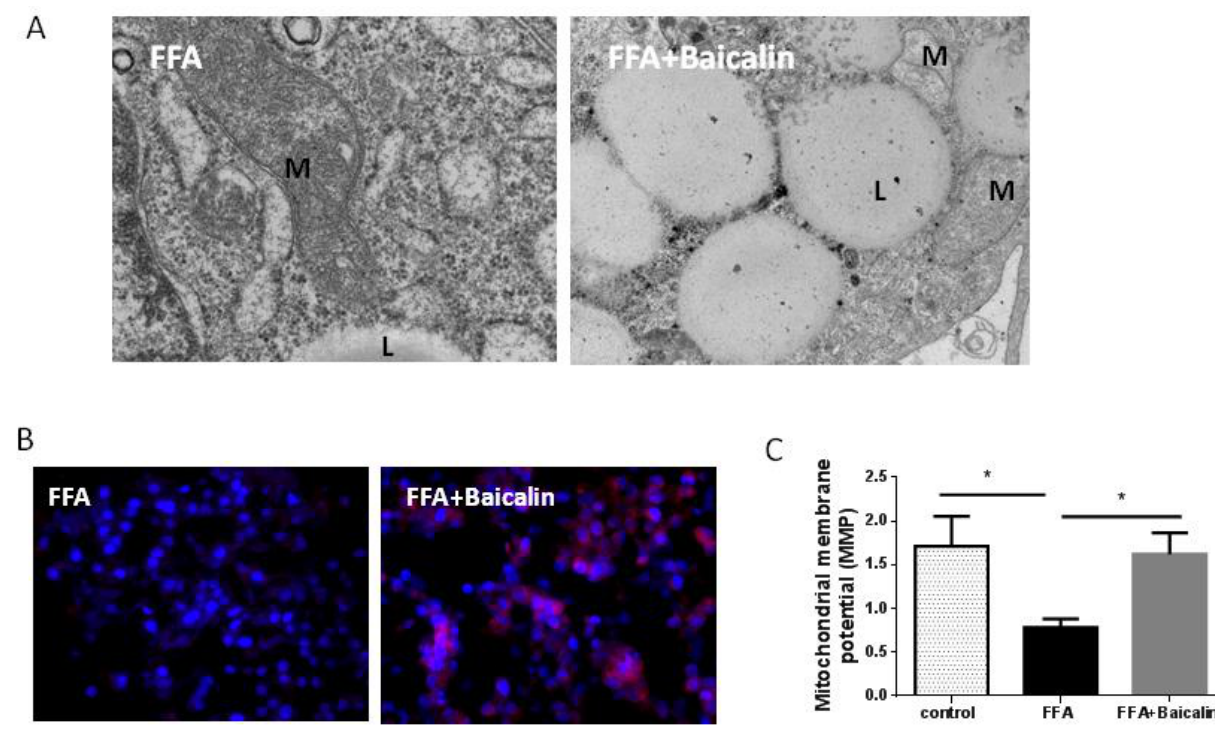
Figure 4. Ultrastructural morphology and function of mitochondria with or without baicalin treat- ment. ( A ) Mitochondrial morphology was observed by transmission electron microscopy. Lipid droplet (L), mitochondrial (M). ( B ) Expression of ATP5A-positive cells (red) in the FFA and baicalin groups. DAPI was used for counterstaining. ( C ) MMP detected with the JC-1 fluorescence probe ( n = 5). * p < 0.05.